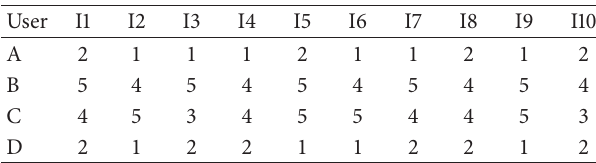
Table 2: Users’ evaluation on 10 items.